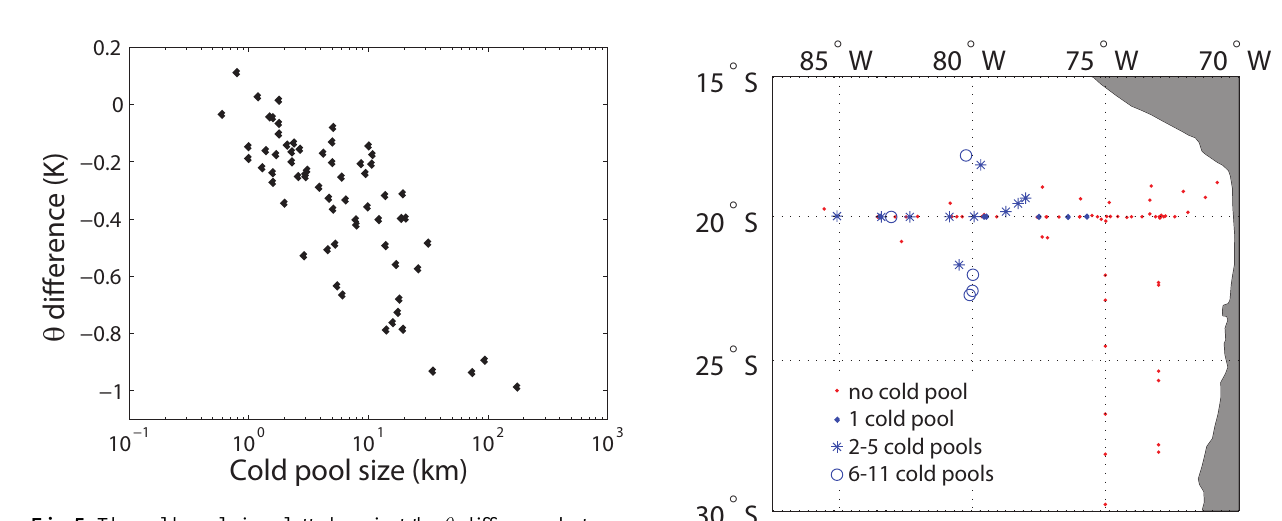
Fig. 5. The cold-pool size plotted against the θ difference between mean θ inside the cold pool and mean θ 2.5km outside the cold pool. Fig. 6. Geographic location of subcloud flight legs flown by the C- 130 during VOCALS-REx. Red dots indicate legs in which no cold pools were observed. Blue dots indicate legs in which 1 cold pool was observed, while the stars indicate where 2–5 and open circles indicate where 6–11 cold pools were